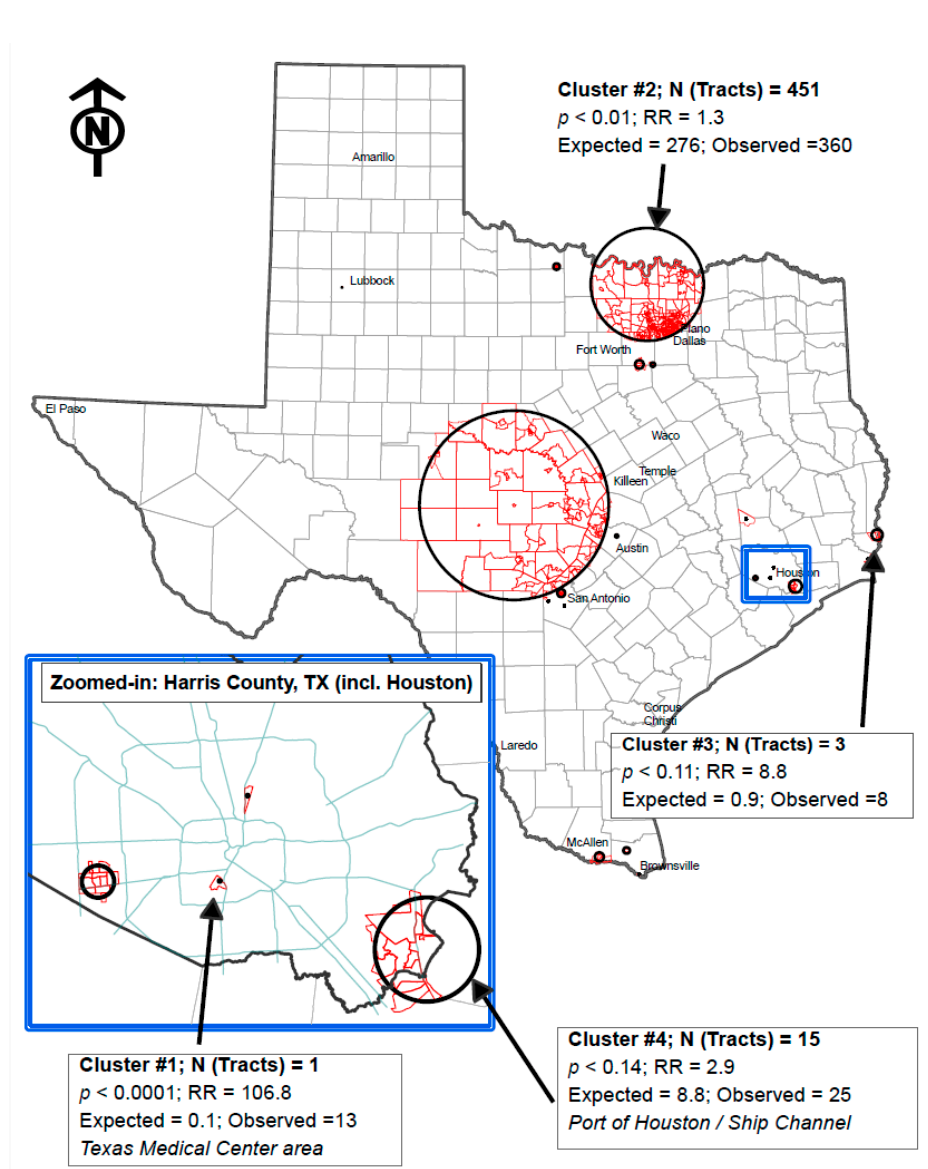
Figure 1. Clusters of pediatric brain tumors in Texas, 2000–2017. Black arrows indicate clusters with a p < 0.15.